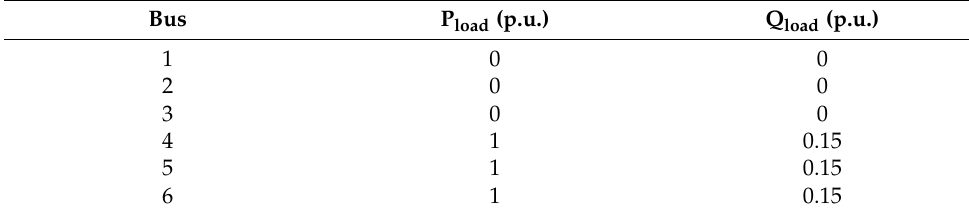
Table 3. IEEE 6-bus test system load values.